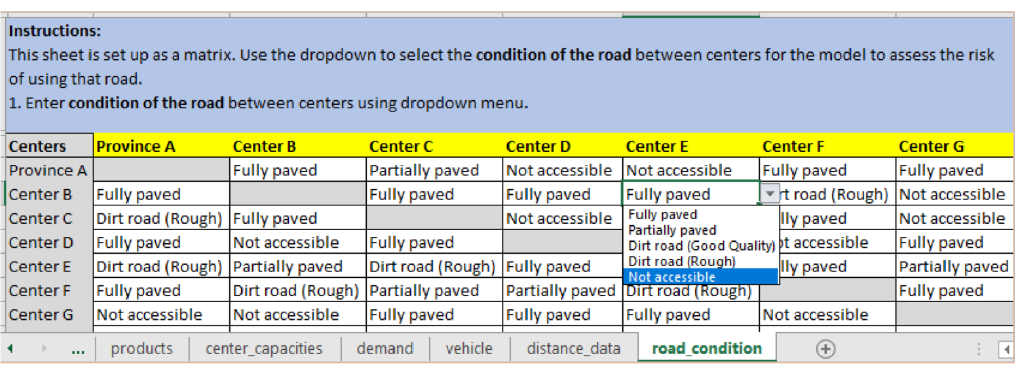
Figure 6. Update the “road_condition” input sheet to reflect current road conditions and accessibility between Centers.